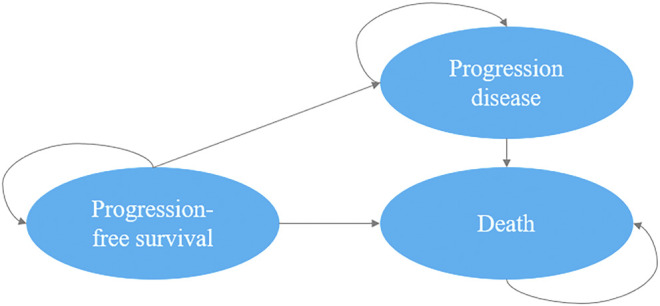
Markov state transition model.